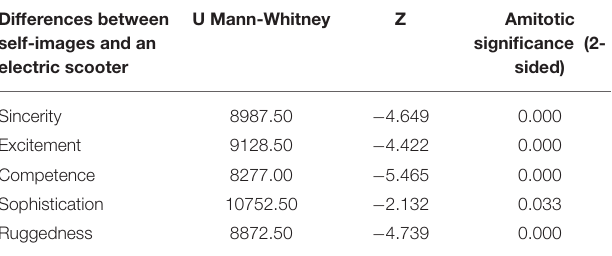
TABLE 1 | Comparison of the Russian and Chinese samples by the criteria of the difference between self-images and the image of an electric scooter on the dimensions of the J. Aaker